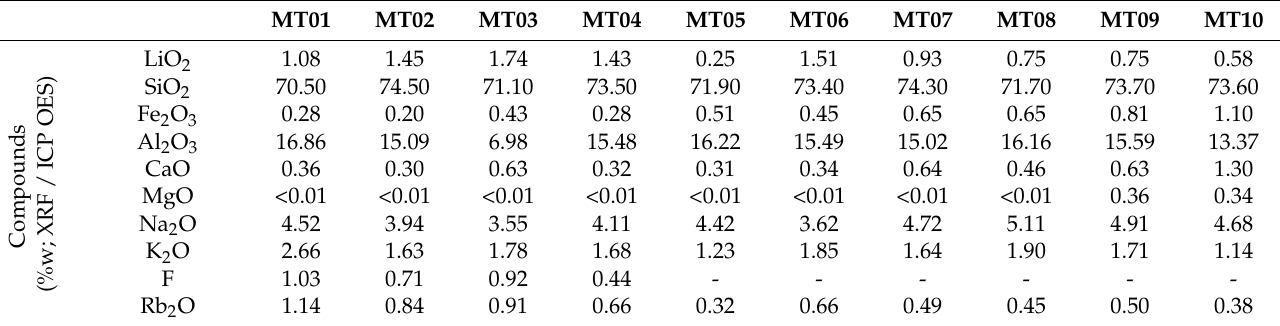
Table 2. Bulk chemical analysis of the samples and SEM-based mineralogical composition of the samples in the fraction of 0.30–0.037